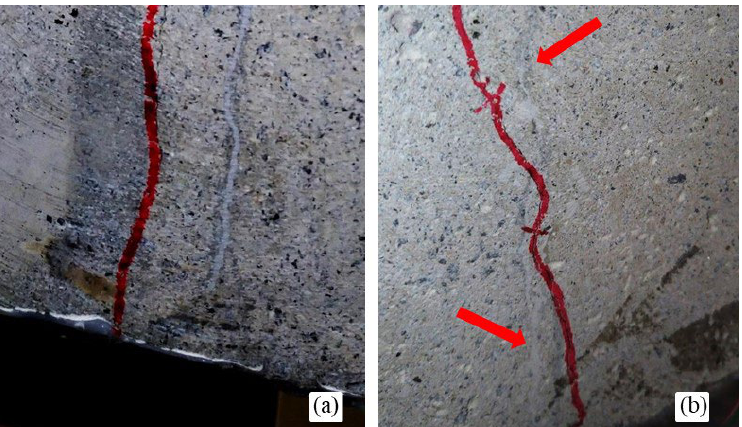
Figure 20. Detail of a new crack next to an injected crack (a); Detail of a new crack crossing an injected crack